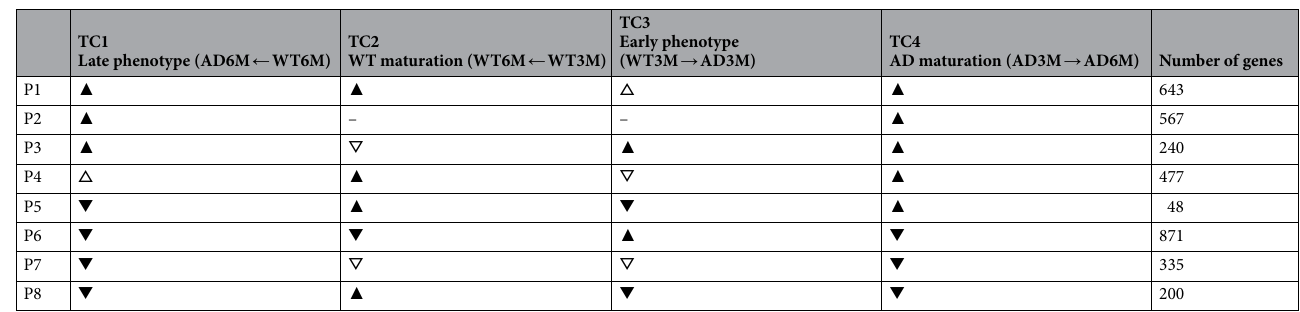
Table 1. Four-way TCs and number of genes in each pattern group. ▲ : up; ▼ : down; △ : even/up; ▽ : even/ down; –: even; AD, Alzheimer’s disease; M, months; P, pattern group; TC, transition curve; WT, wild